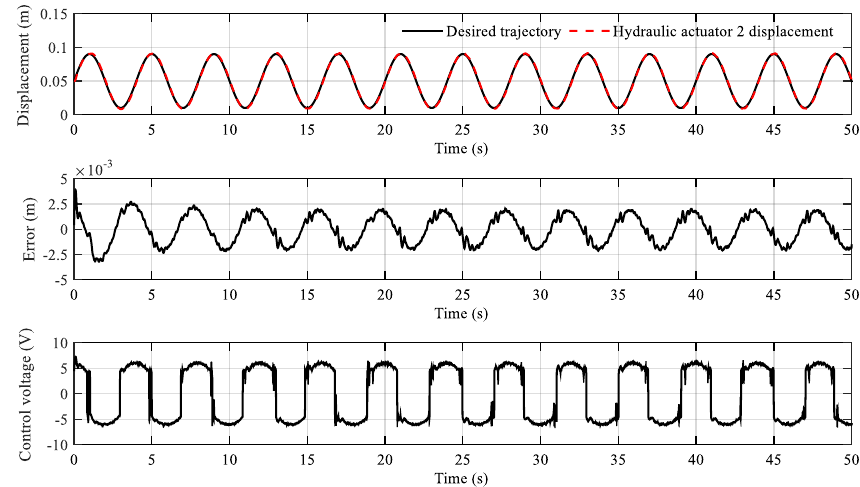
Figure 10. Sinusoidal trajectory tracking curve of hydraulic actuator 2.